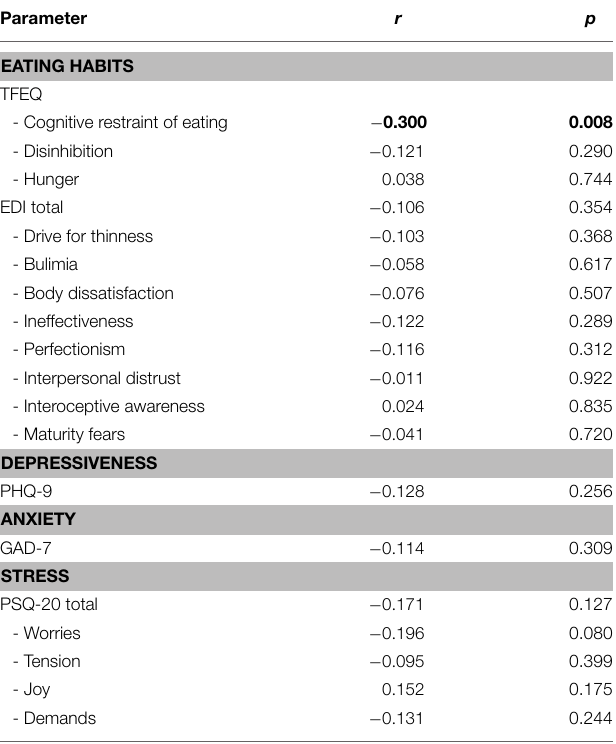
TABLE 6 | Correlation of plasma bile acids with psychometric parameters in a population of obese patients with broad spectrum of disordered eating, depressiveness, anxiety, and